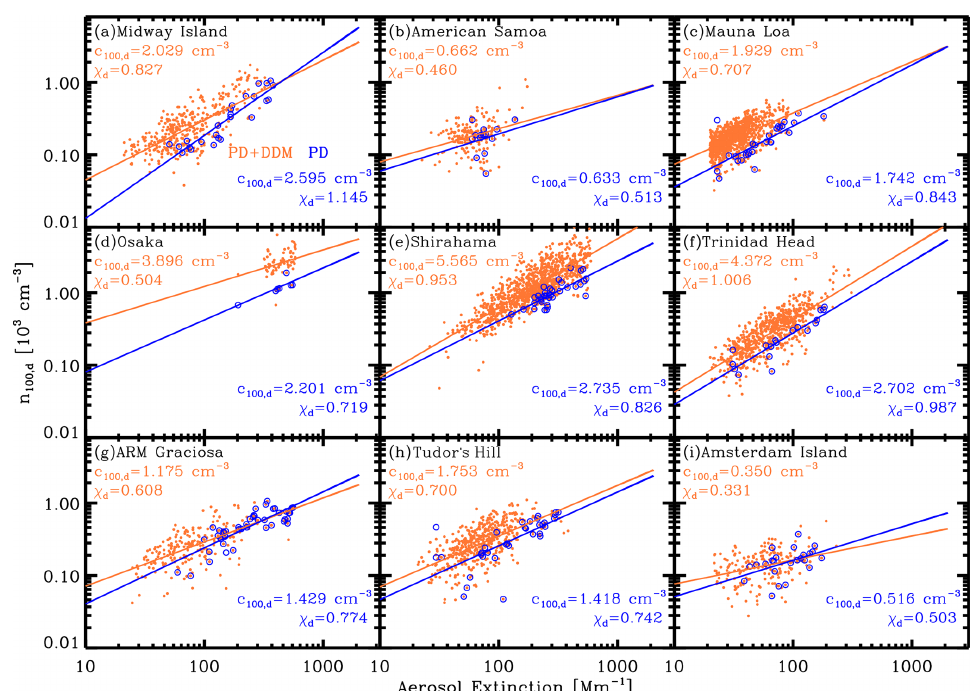
Figure 7. Relationship between aerosol extinction coefficient at 532nm and aerosol particle number concentration n 100 , d (radius > 100nm) for DDM+PD (in orange) and PD (in blue) at nine ocean and coast sites, i.e., (a) Midway Island, (b) American Samoa, (c) Mauna Loa, (d) Osaka, (e) Shirahama, (f) Trinidad Head, (g) ARM Graciosa, (h) Tudor Hill, and (i) Amsterdam Island. The PD and DDM data points are selected from the AERONET Version 3 database (level-2.0 AOD products and level-1.5 aerosol inversion products) using the dust ratio threshold derived with the method given by Shin et al. (2019). The corresponding dust-related conversion factors c 100 , d and χ d are also